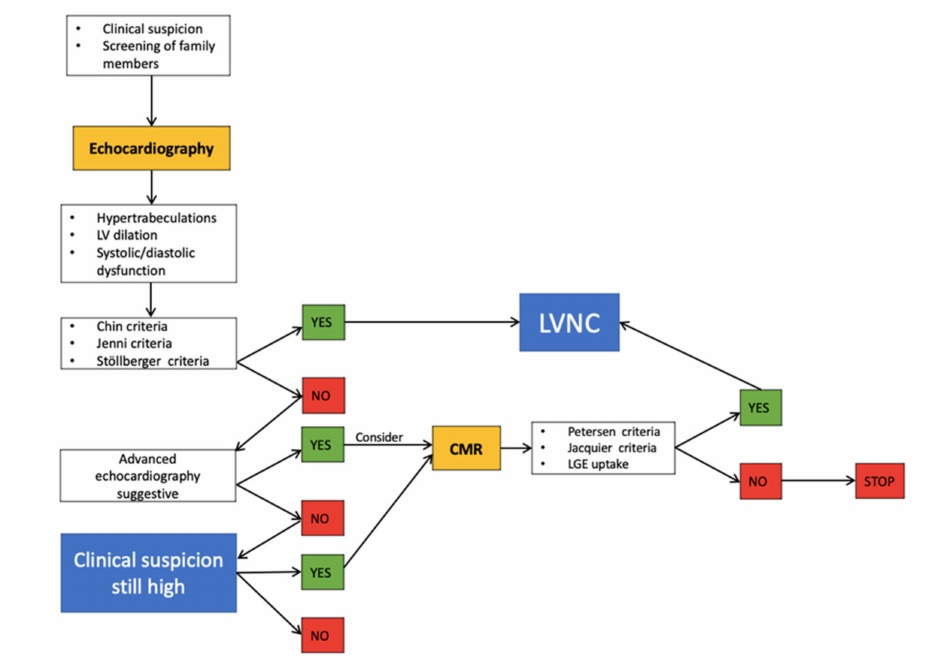
Figure 5. Proposed stepwise diagnostic